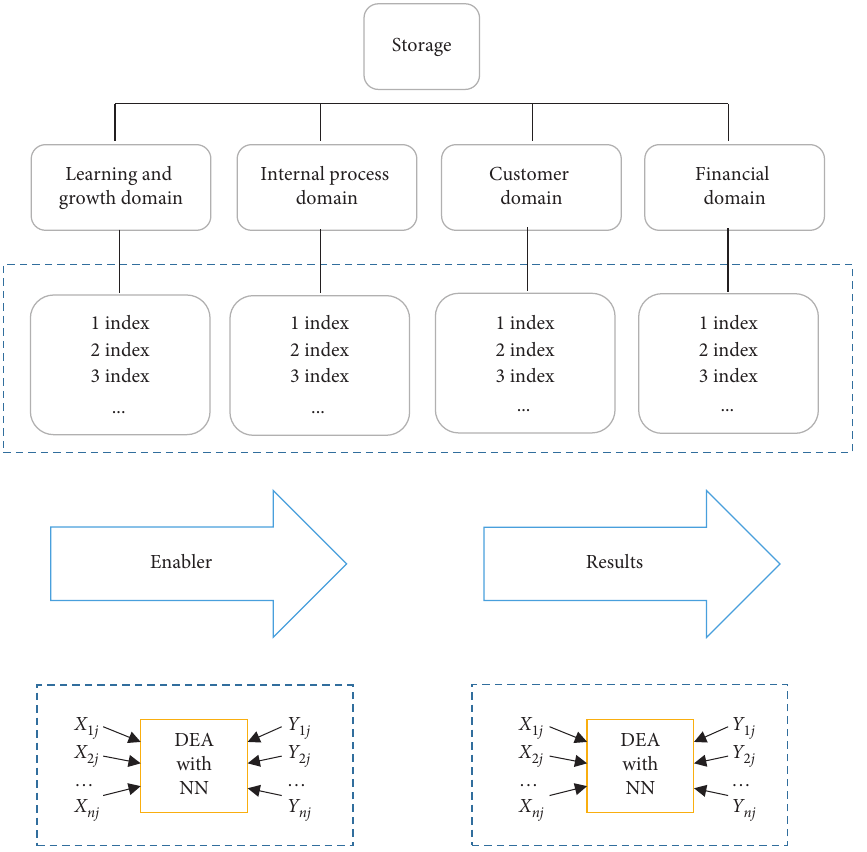
Figure 4: A hybrid BSC-DEA strategy with neutrosophic